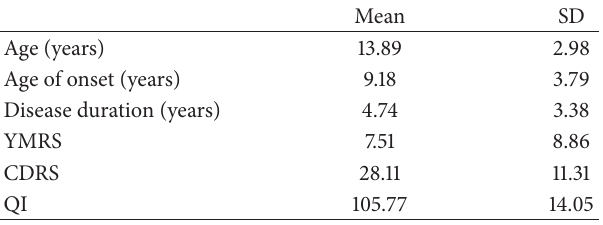
Table 1: Demographic data ( 𝑁 = 27